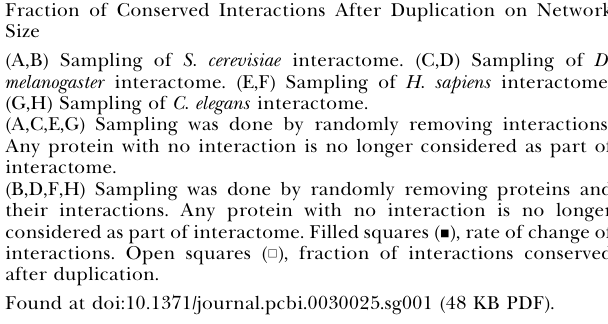
Figure S1. Dependence of the Calculated Rate of Change and Fraction of Conserved Interactions After Duplication on Network Size (A,B) Sampling of S. cerevisiae interactome. (C,D) Sampling of D. melanogaster interactome. (E,F) Sampling of H. sapiens interactome. (G,H) Sampling of C. elegans interactome. (A,C,E,G) Sampling was done by randomly removing interactions. Any protein with no interaction is no longer considered as part of interactome.